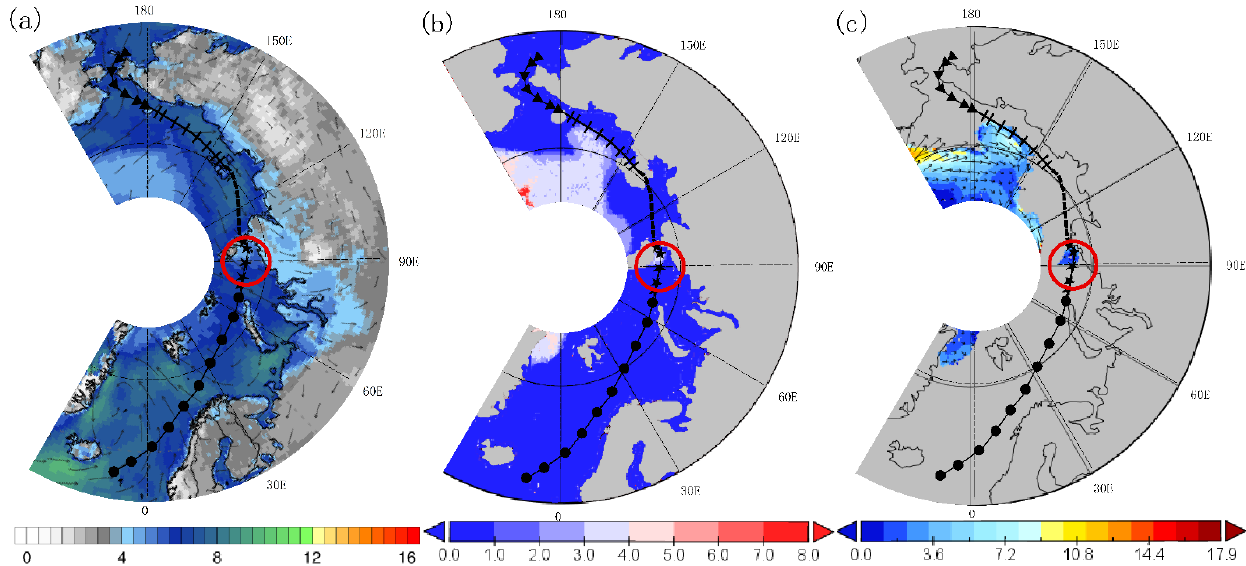
Figure 18. The average wind field ( a ), sea ice age ( b ) and sea ice movement ( c ) of the NEP in the Arctic in August 2013.